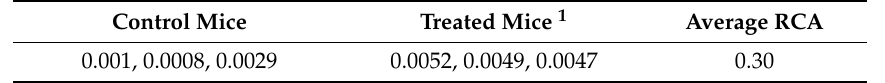
Table 2. Frequencies of resistant bacteria in the Resistance Competition